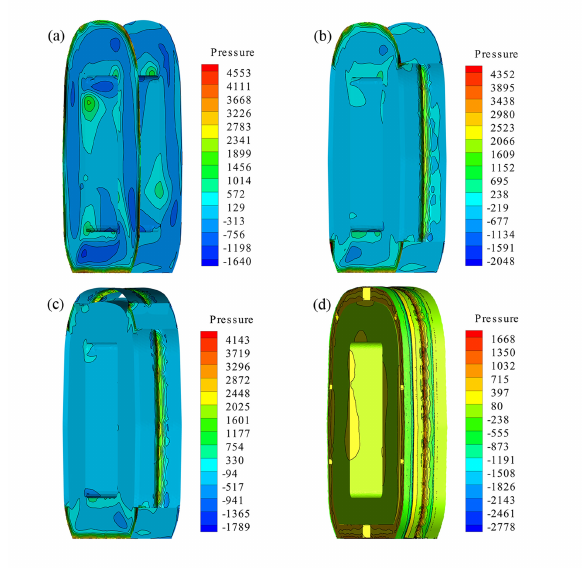
Fig. 9. Pressure analysis: (a) Inner windshield pressure nephogram (b) Bodyside windshield pressure nephogram (c) Body side and top windshield pressure nephogram (e) Mechanical windshield pressure nephogram.